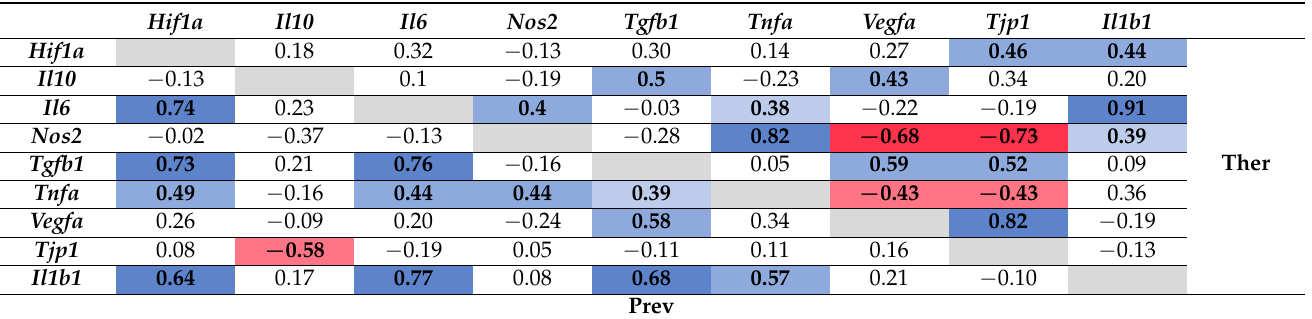
Table 3. Correlation between inflammatory and oxidative stress mRNA expression in the DSS model in both therapeutic and preventive